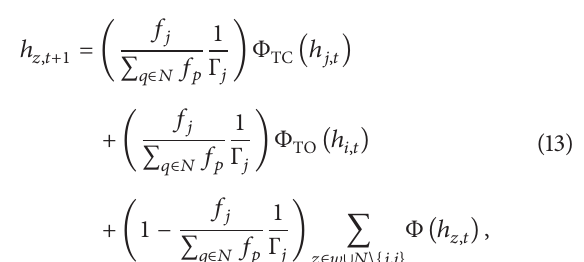
remains with its current strategy; old coordinator configures as a temporary ordinary (TO) node, with the probability of being proportional to fitness. More- over, the neighbor player keeps the strategy and configuration until the jamming attack weakens and old coordinator node recovers its role, as shown in Figure